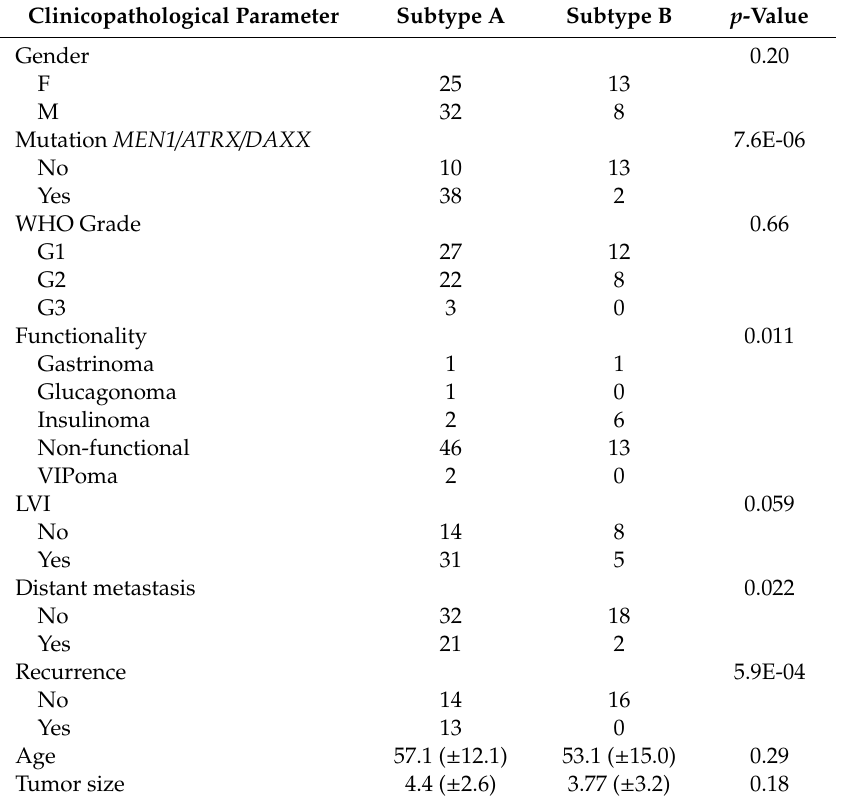
Table 1. Association between clinicopathological characteristics and